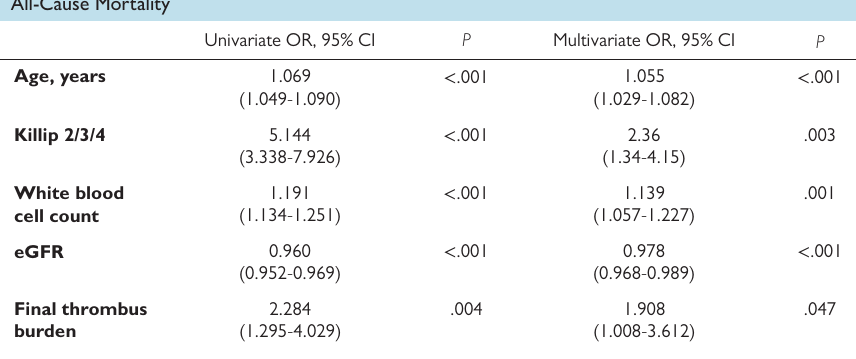
Table 6. Results of a Multivariate Logistic Regression Analysis Performed to Estimate 1-Year All-Cause